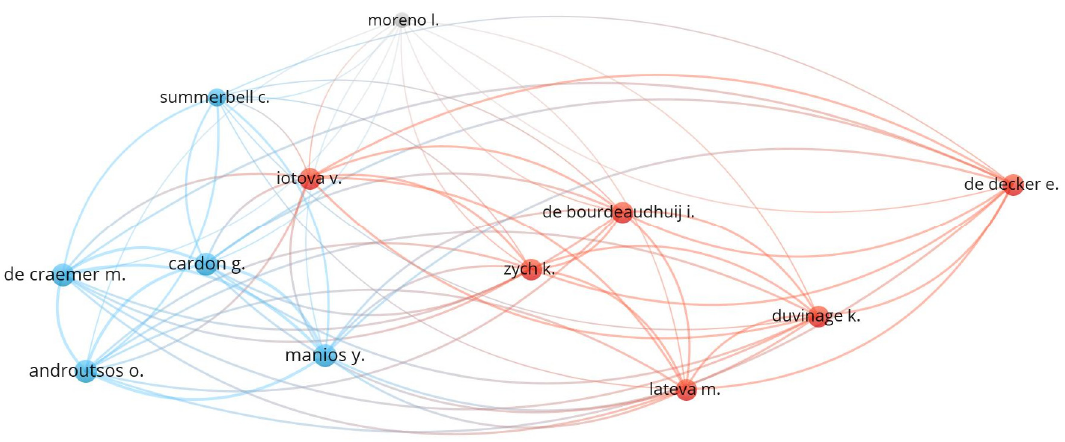
Figure 5. Network of cooperation based on co-authorship between authors (2004–2018).